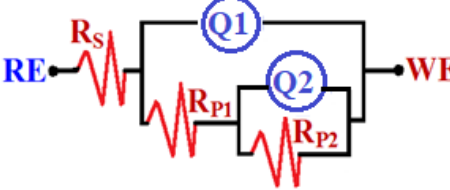
Figure 5. Nyquist plots for (1) Ti and (2) Ti85-Zr15 after 72 h exposure to SBF.